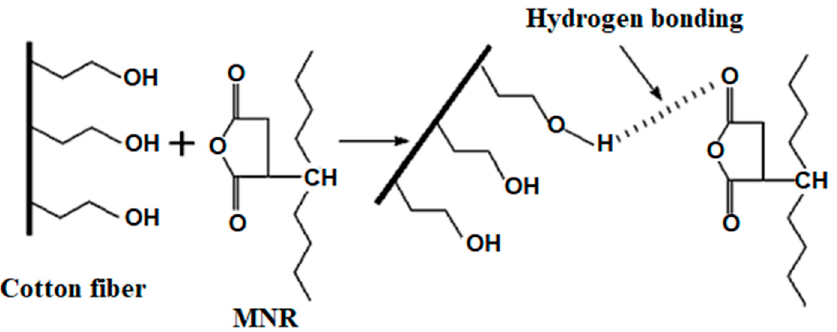
Figure 7. Schematic representation of the interaction between cotton fiber and MNR through hydro- gen bonding (reproduced with permission from [27]).